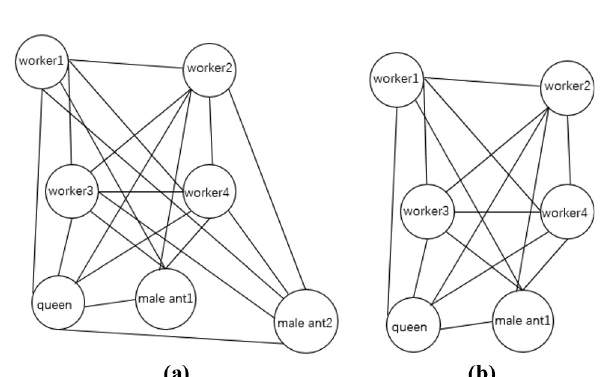
Figure 6. Two ant colony